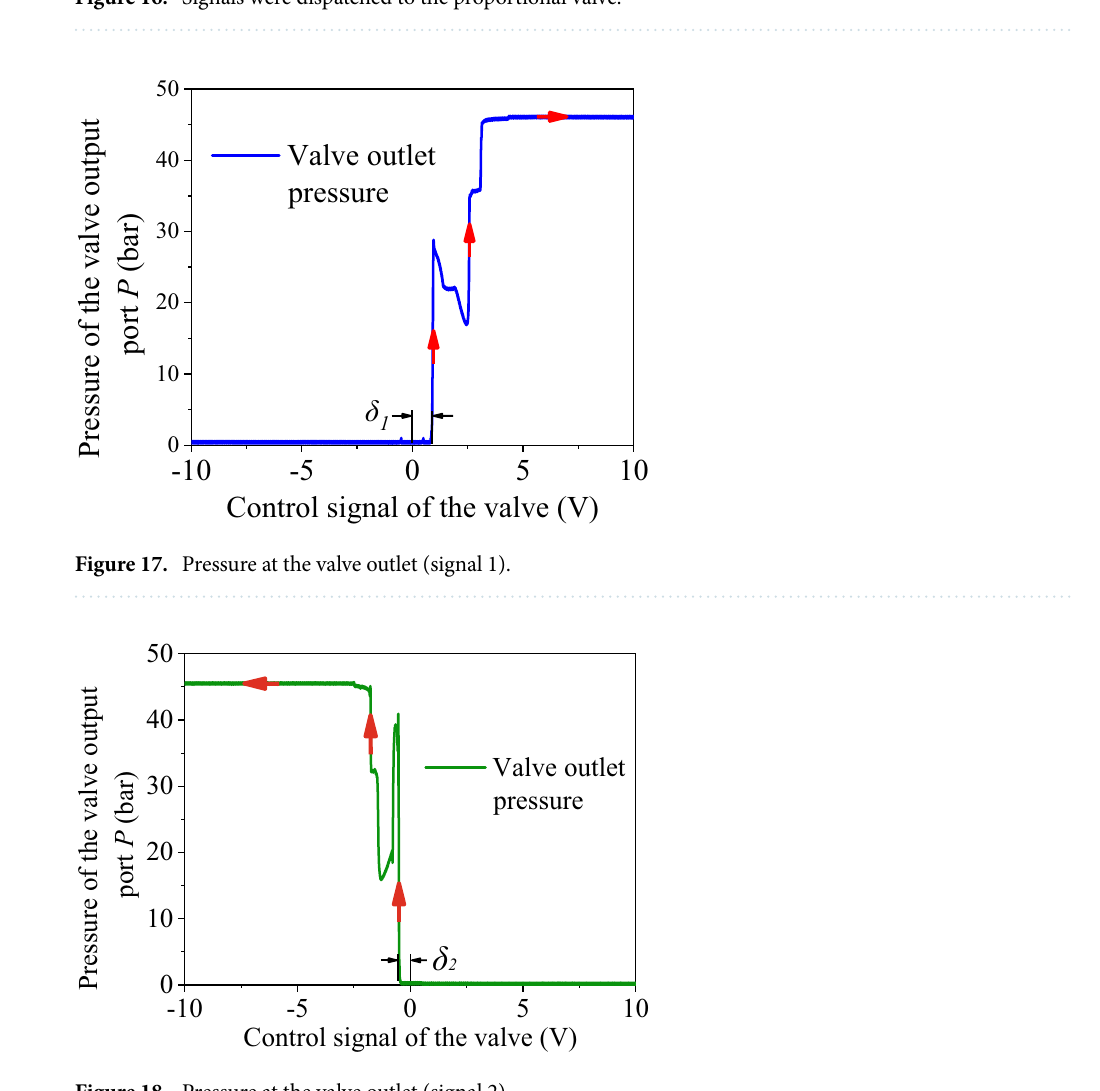
Figure 16. Signals were dispatched to the proportional valve.